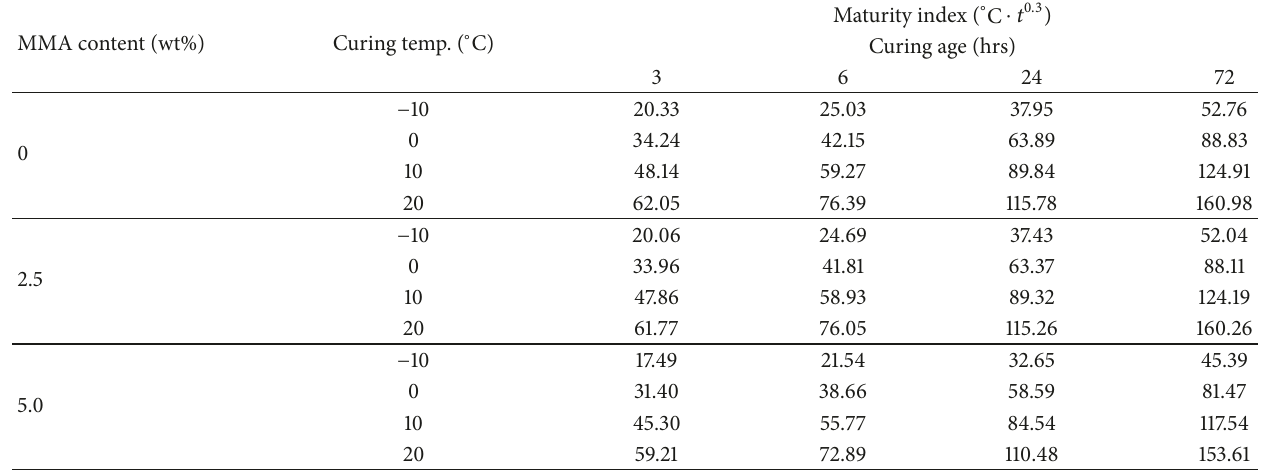
Table 12: Estimation results of the maturity